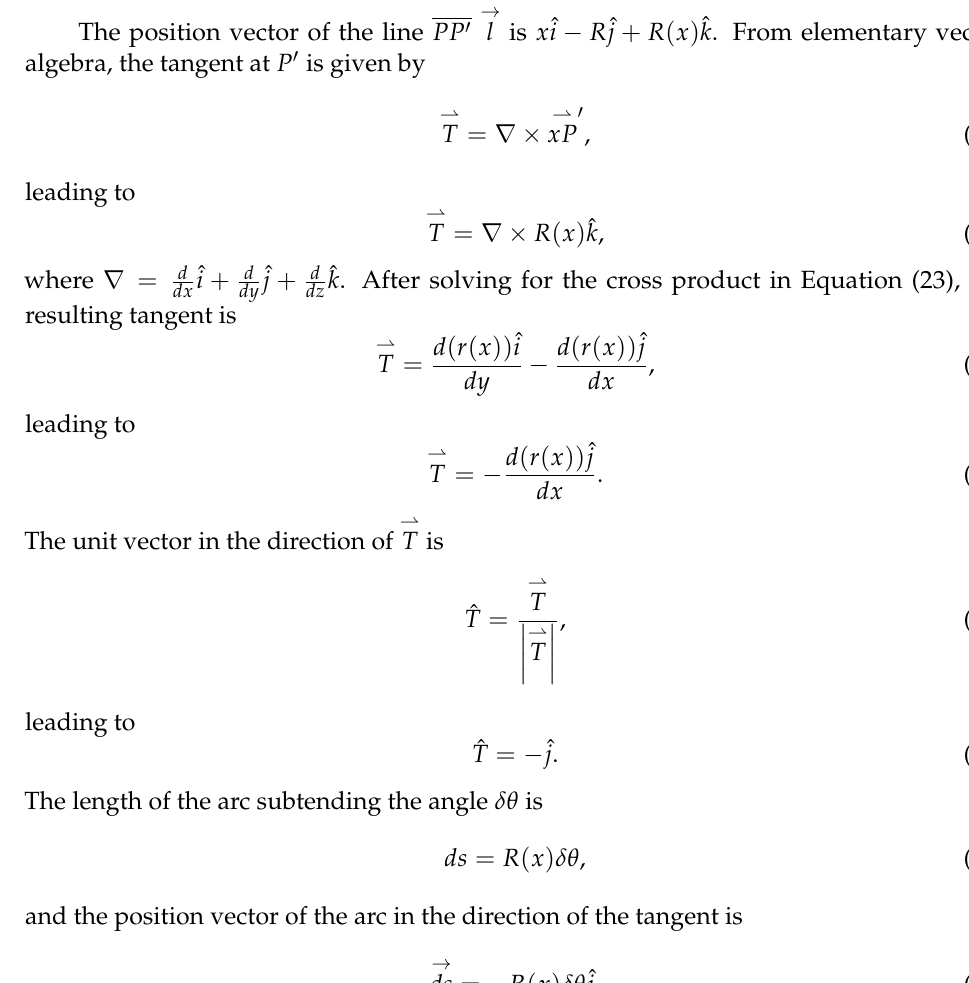
Figure 3. CV of the wake of an